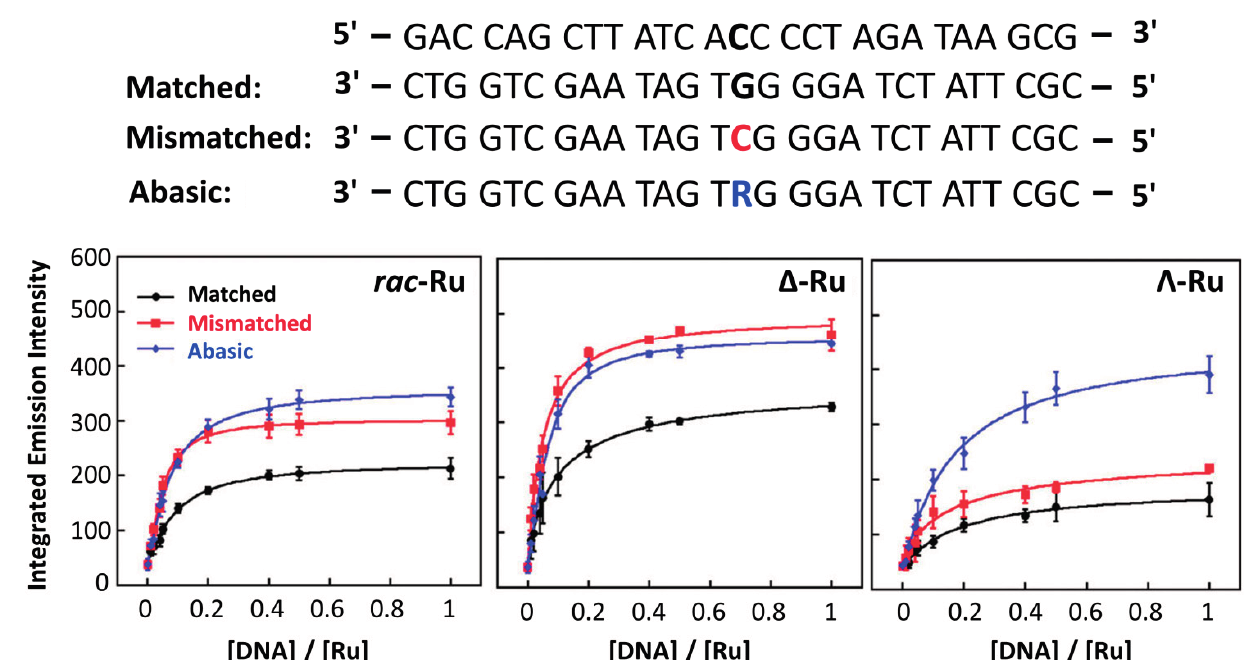
Figure 28. DNA detection with Ru[(bpy) ref. [294], copyright (2009) American Chemical